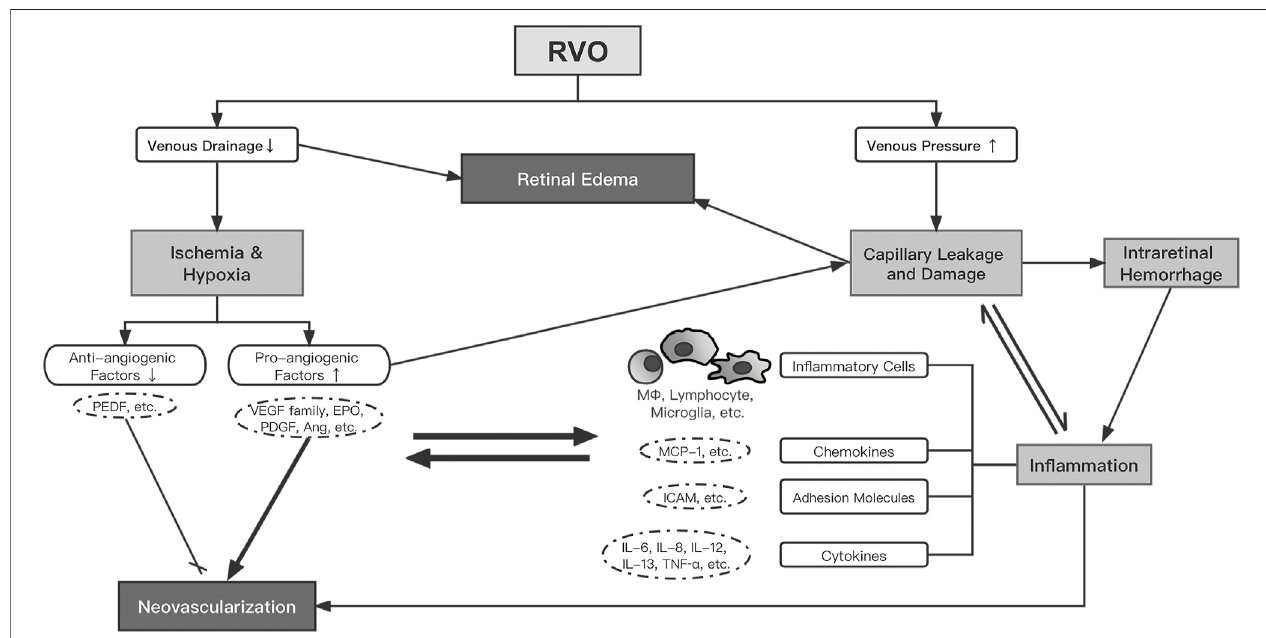
FIGURE 1 | The proposed network of pathogenesis in RVO. Abbreviations: RVO, retinal vein occlusion; VEGF, vascular endothelial growth factor; EPO, erythropoietin; PDGF, platelet-derived growth factor; Ang, angiopoietin; PEDF, pigment epithelium-derived factor; M Φ , macrophage; ICAM, intercellular adhesion molecule; IL, interleukin; MCP, monocyte chemoattractant protein; TNF, tumor necrosis